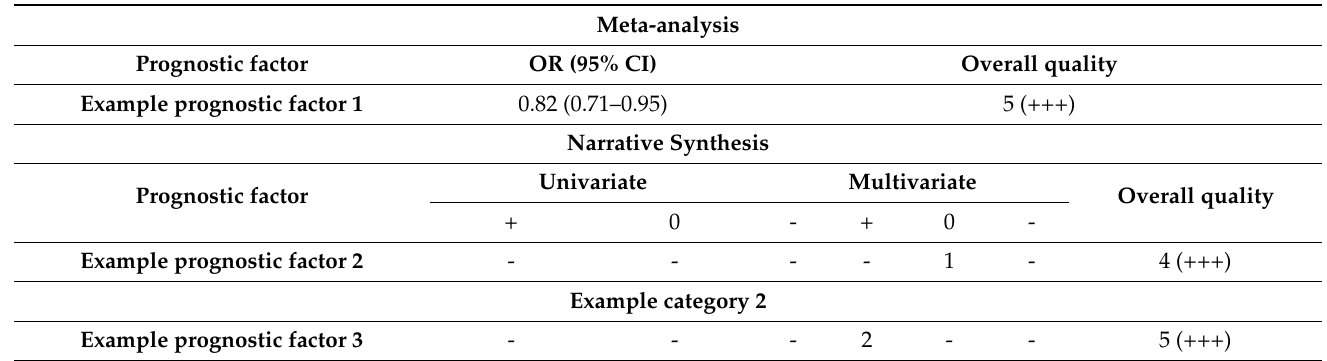
Table 2. Example of summary of findings